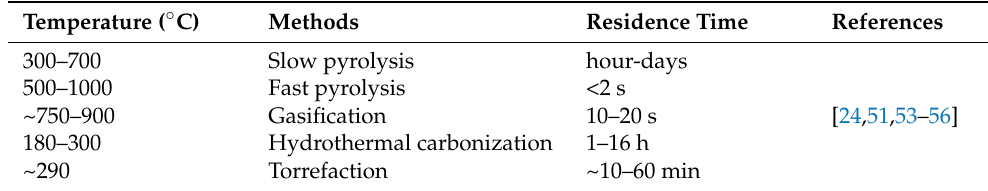
Table 1. Methodologies for producing